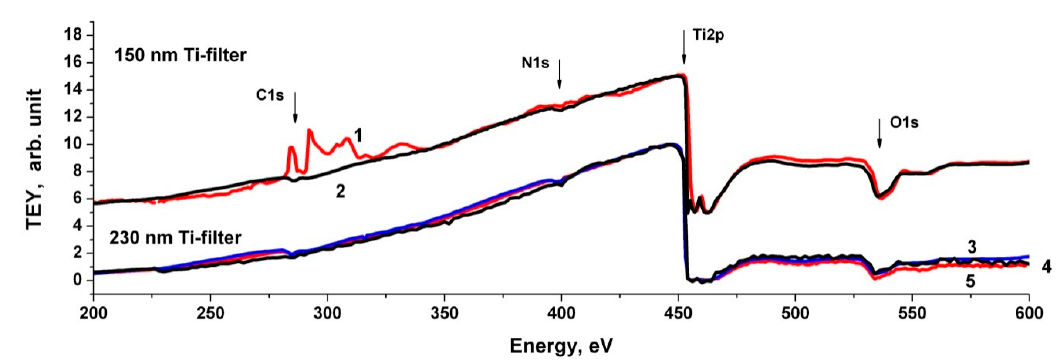
Figure 9. The I 0 E 0 j ( E 0 ) spectral dependences measured by the TEY method using Ti filters with a thickness of 150 nm and 230 nm and various photocathodes: HOPG (1), copper (3), silicon (4) and gold (2.5).